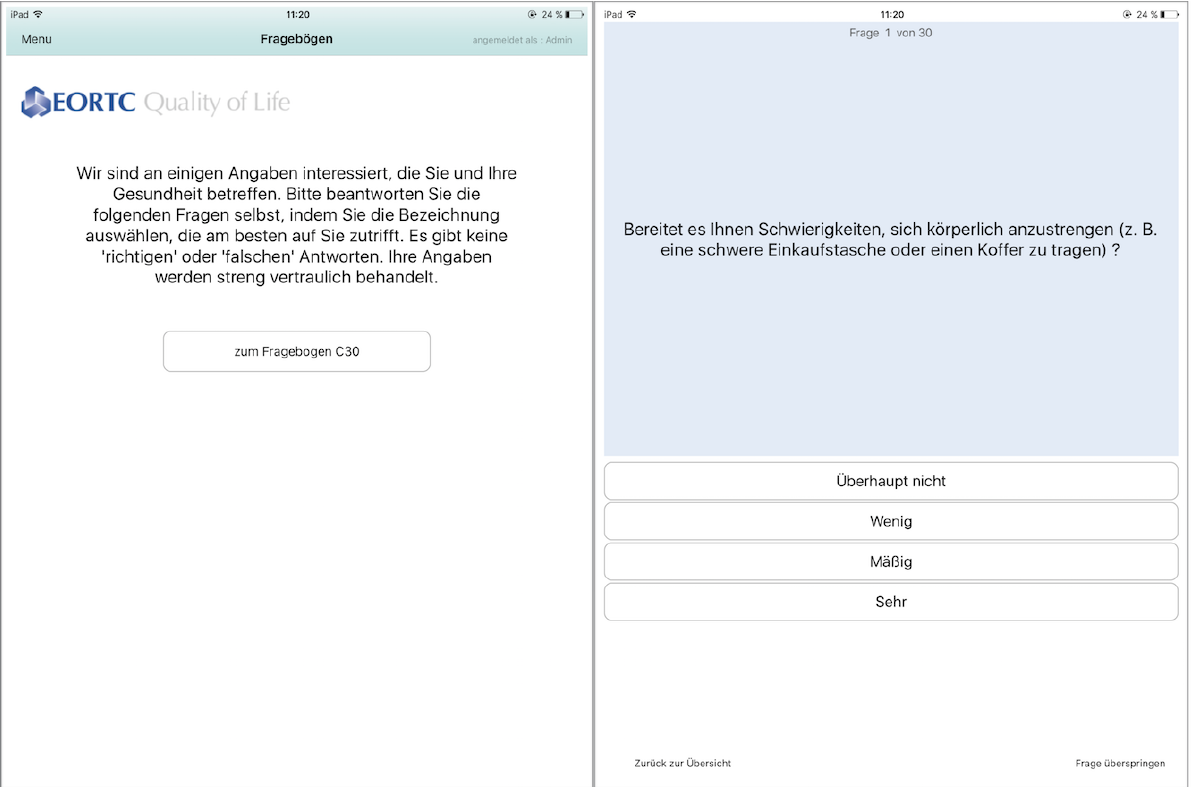
Figure 3. Screenshot of the start page of the European Organization for Researchand Treatment of Cancer Quality of Life Questionnaire-Core 30 (EORTC QLQ-C30; left) and the first question